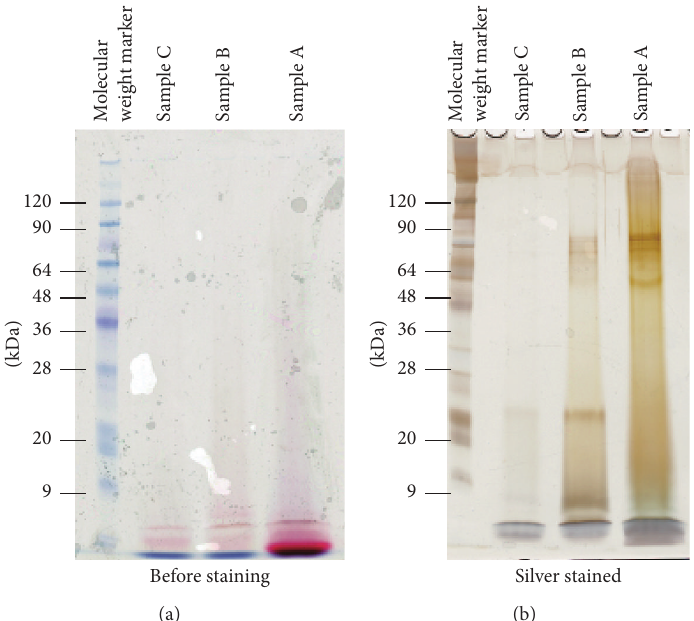
Figure 5: (a) Image of acrylamide gel immediately after SDS-PAGE for protein contaminants in carmine with the Amicon Ultra-0.5. (b) Silver